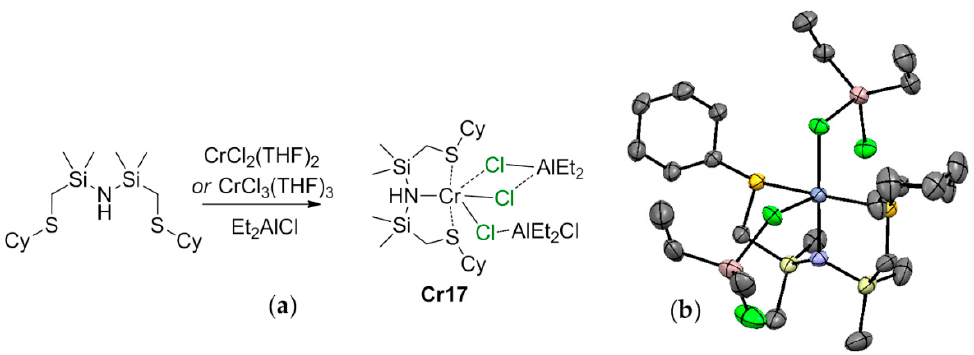
Figure 34. ( a ) Synthesis of complex Cr17 ; ( b ) ORTEP view of Cr17 (hydrogen atoms are omitted) [253].